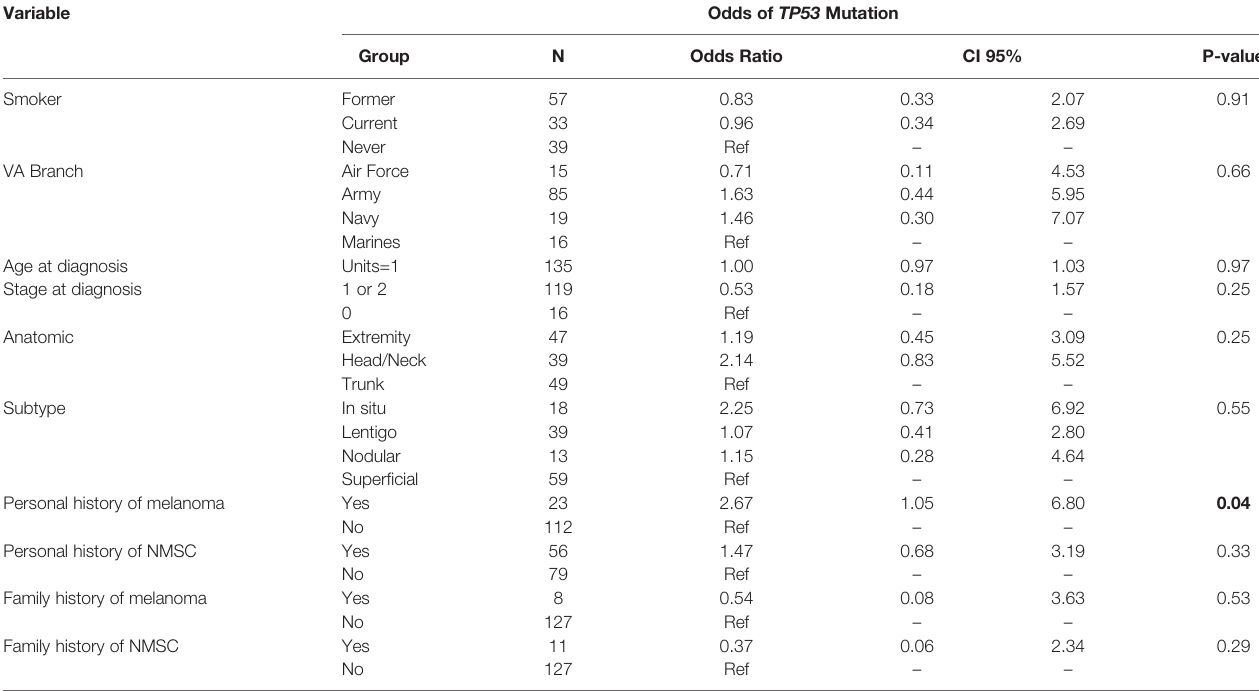
TABLE 6 | Univariate analysis between demographic and clinical factors and TP53 mutations. Variable